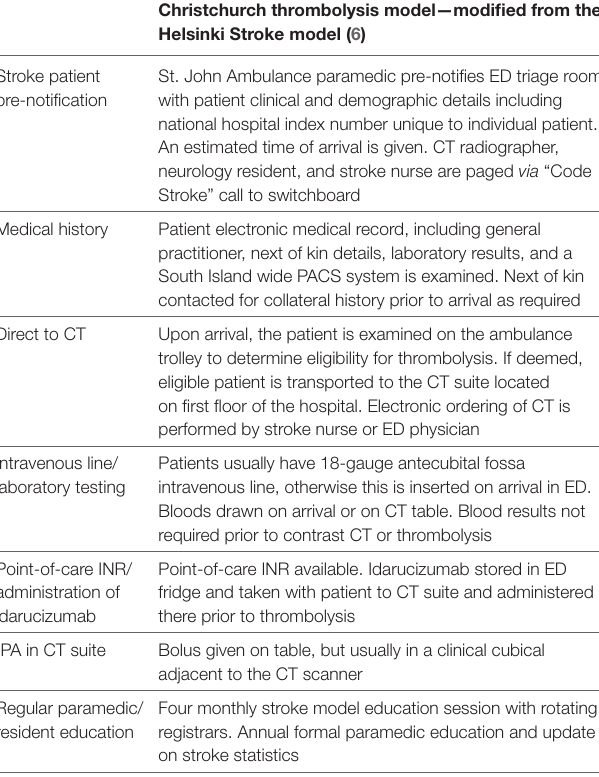
TaBle 1 | The new stroke thrombolysis model in Christchurch